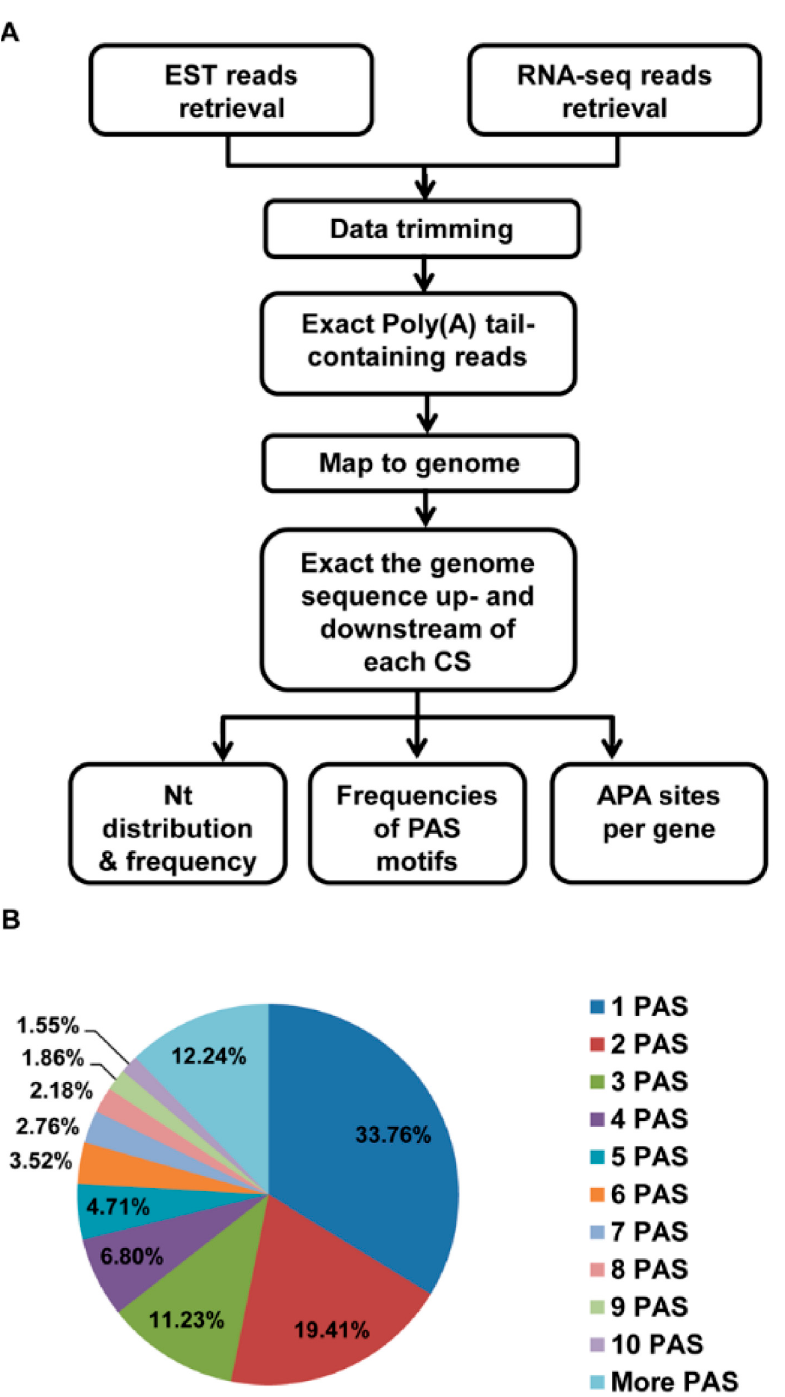
Figure 1. Identification of poly(A) sites and pA clusters. ( A ) The outline of using the RNA-seq and EST data to extract sequences of poly(A) sites and PAS in Sus scrofa . The RNA-seq data were obtained from the transcriptomes of Sus scrofa and EST data were obtained from the NCBI EST database. The data were first trimmed and the useless data were removed by filtering. The remaining data were mapped to the genome. The sequence upstream and downstream of the mapped reads and the tags were then extracted, and then the false sites from genome inter poly(A) regions were removed. The final data were used to analyze the PAS. ( B ) PASs considered as a cluster by separating 20 or less